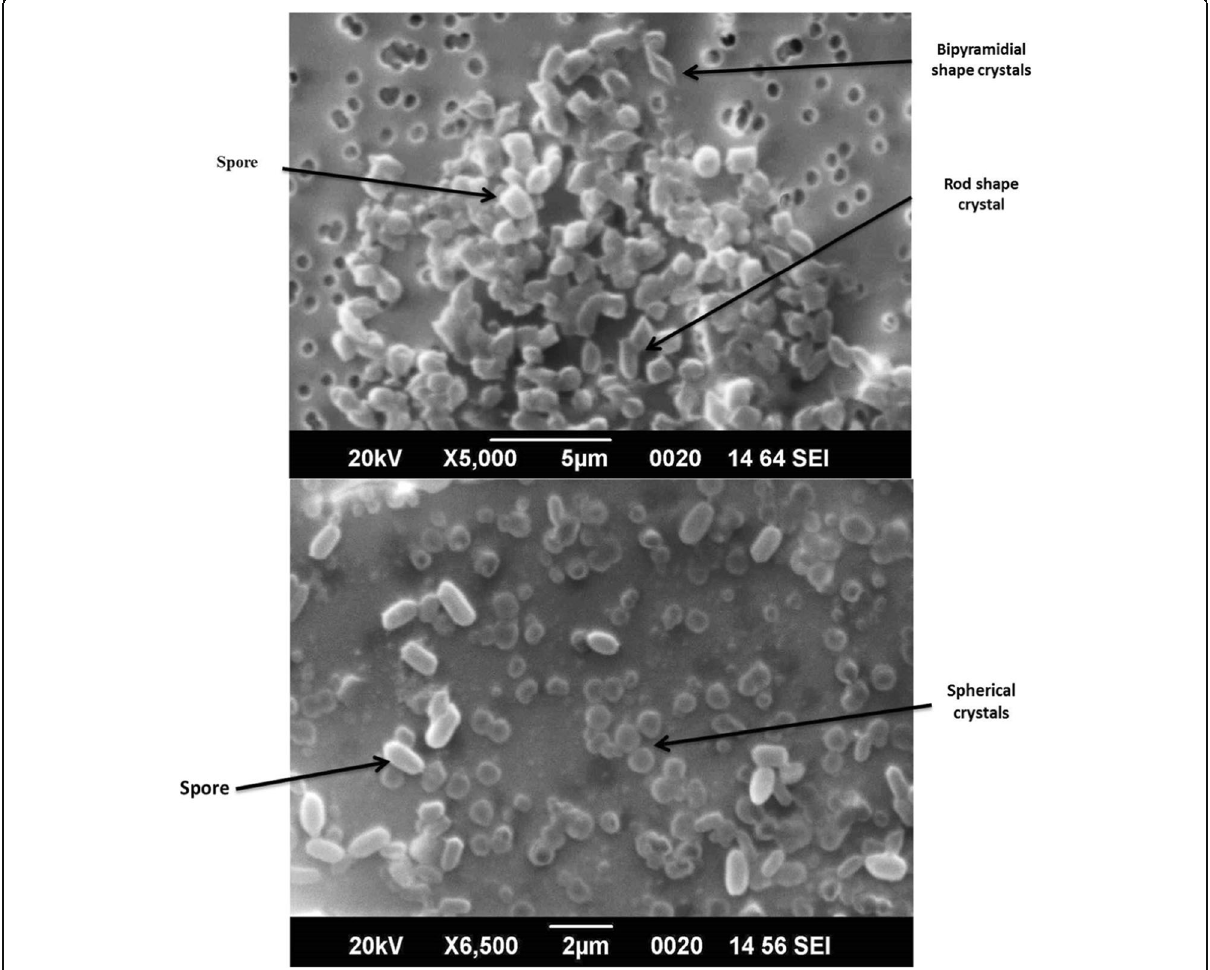
Fig. 2 Scanning electron micrograph of a sporulating culture of Bacillus thuringiensis isolates, ( a ) Damietta isolate and ( b ) EL-Sharkyia